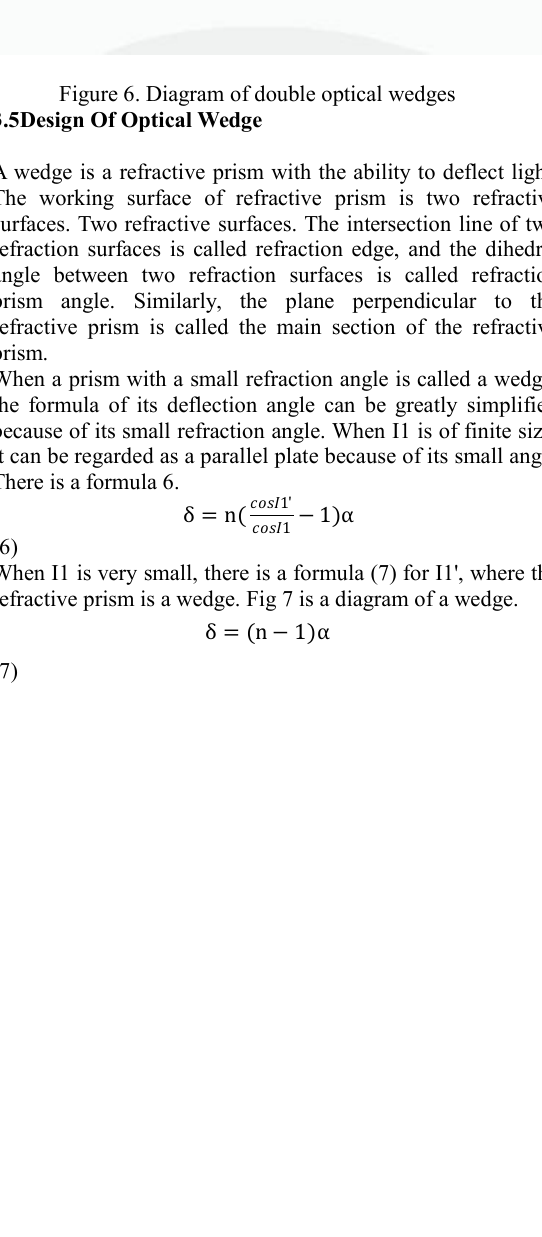
Figure 7. Diagram of optical wedge Tan theta = 0.175 is calculated from formula 4. The inverse